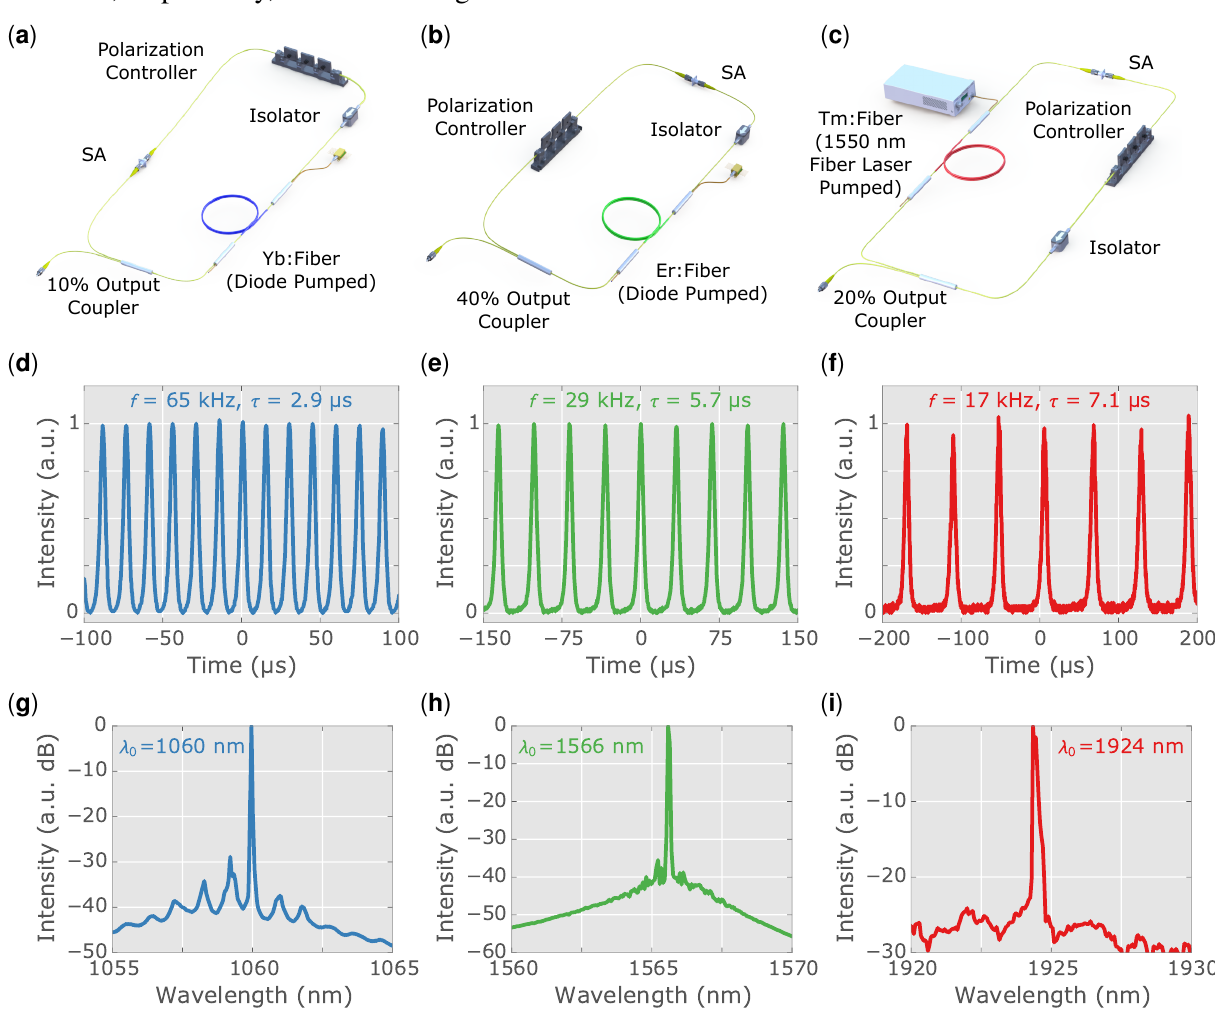
Figure 5. Q-switched fibre lasers with MoSe -PVA saturable absorber, after [55]: 2 ( a – c ) cavity schematics; ( d – f ) output pulse trains showing the repetition rate f and pulse duration τ ; ( g – i ) spectra. The columns (left to right) show Yb, Er and Tm laser